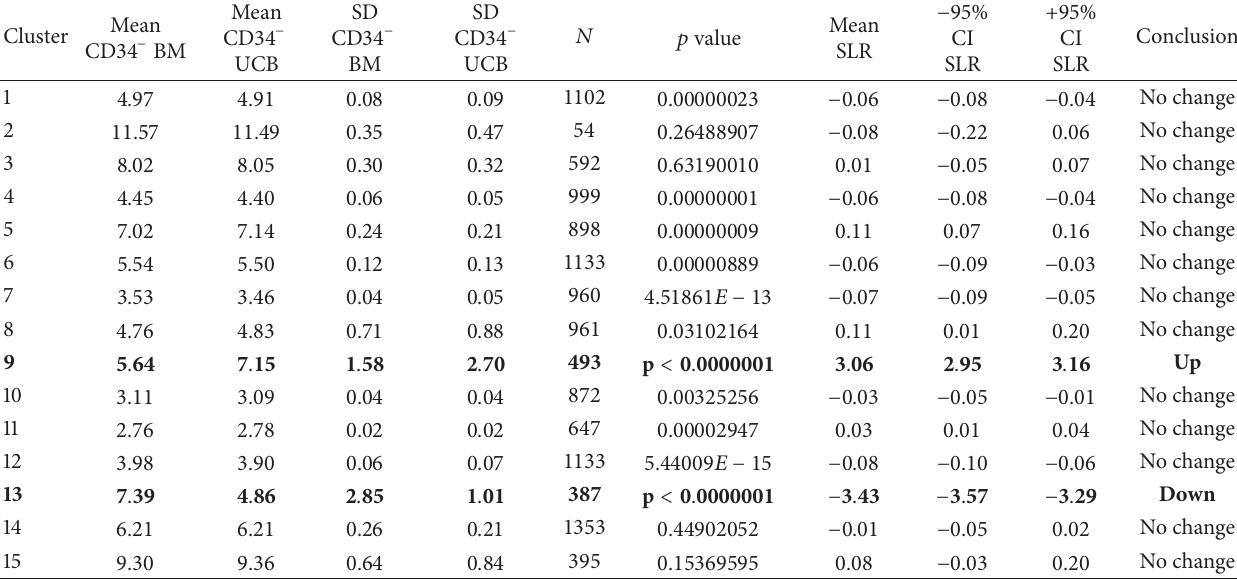
Table 1: 15 clusters obtained as a result of the unsupervised gene clustering. Mean CD 34 − BM (mean of CD 34 − stem cells from bone marrow).